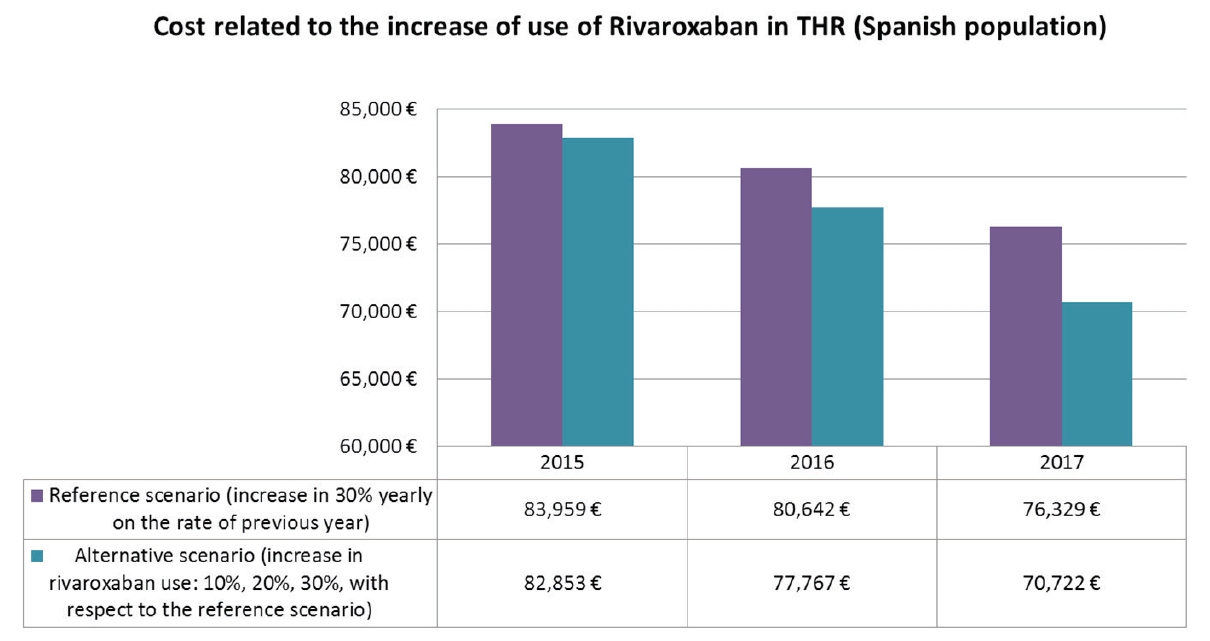
Figure 1. THR Cohort Costs 2015-2017, Spanish Population; THR Cohort Total Costs 2015-2017 in the Basecase and alternative Scenarios in Spain Estimated on the Basis of Event Rates from the Spanish Population of the XAMOS Study